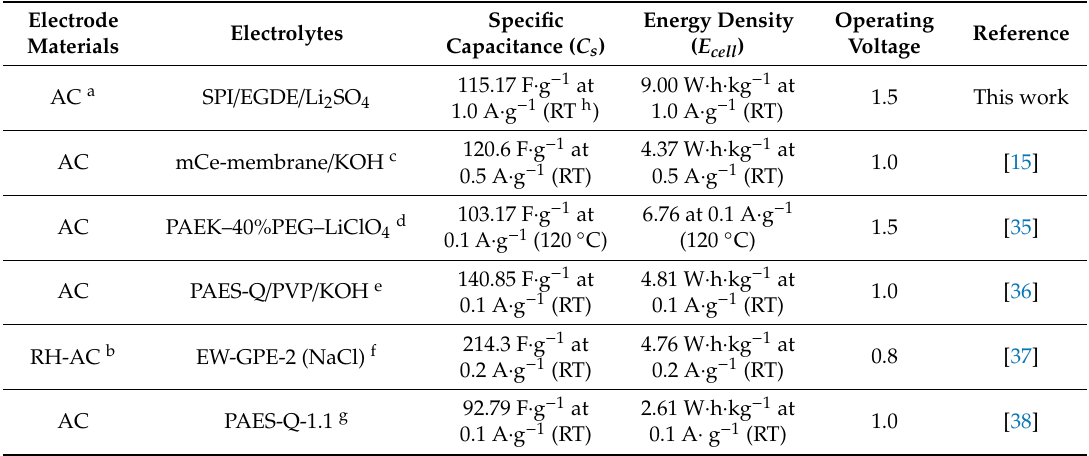
Table 1. Performance comparison of s-EDLC-20% prepared in this work with the supercapacitors based on di ff erent polymer electrolytes from previous